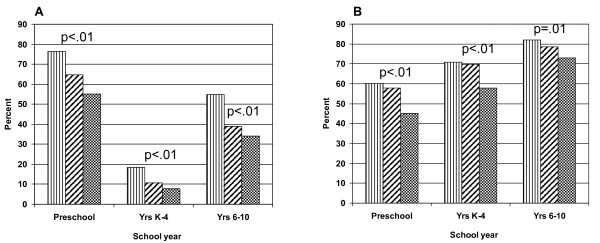
The proportion of children who do not meet guidelines for (A) physical activity or (B) screen time by the level of self-efficacy reported by parents*. Vertical lines < = 25th Perc. Diagonal lines >25- < 75th Perc. Black and white squares > = 75th Perc. *p-values derived from Chi-square test of independence